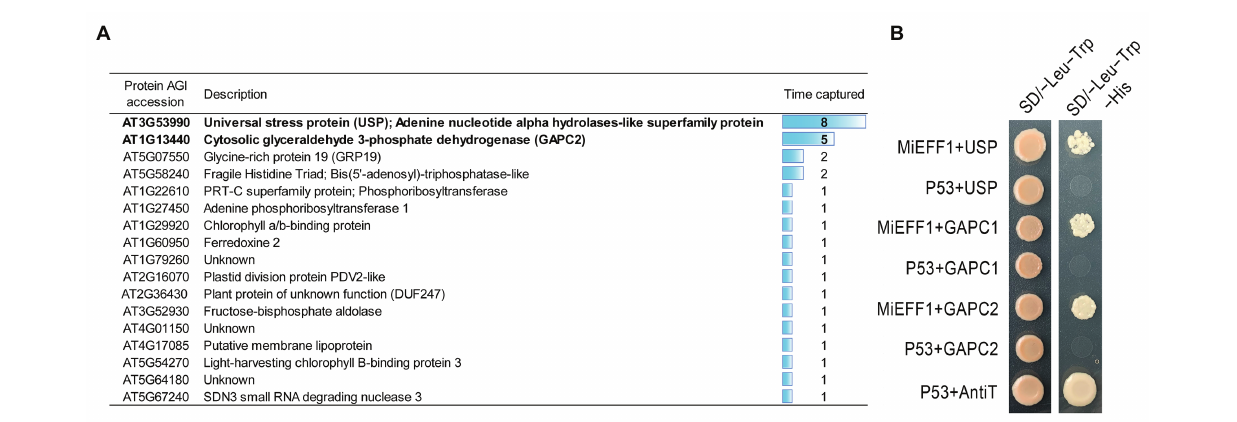
FIGURE 1 | MiEFF1 interacts with AtUSP, AtGAPC1, and AtGAPC2 in yeast. (A) List of putative MiEFF1-interacting proteins from Arabidopsis obtained in our Y2H screen. (B) Yeasts containing the bait and prey plasmids carrying MiEFF1 and AtUSP, AtGAPC1, or AtGAPC2 and controls were spotted onto plates. SD/ − Leu-Trp (Leu, leucine; Trp, tryptophane) is the non-selective medium without leucine and tryptophan. Only yeasts carrying a protein-protein interaction can survive on SD/ − Leu-Trp-His (His, histidine) selective medium. Murine p53 and SV40 T antigen (anti T) were used as a positive control. Murine P53 and AtUSP, AtGAPC1, or AtGAPC2 were used as a negative